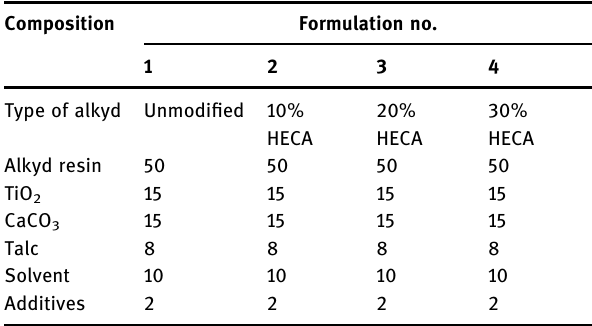
Table 6: Percent composition of the prepared anticorrosive primer